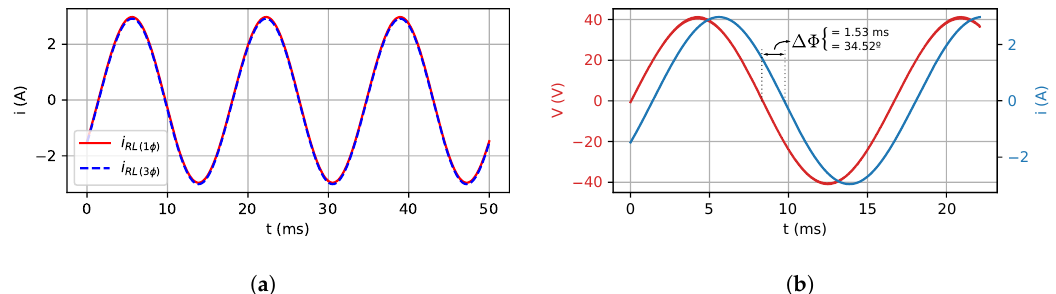
Figure 17. RL load case: ( a ) Load phase currents of single-phase and three-phase (leg 1) models; ( b ) Load phase voltage and current of the single-phase model. Table 3. RMS (root mean square), average, and peak-to-peak values for the simulated currents and voltages: RL